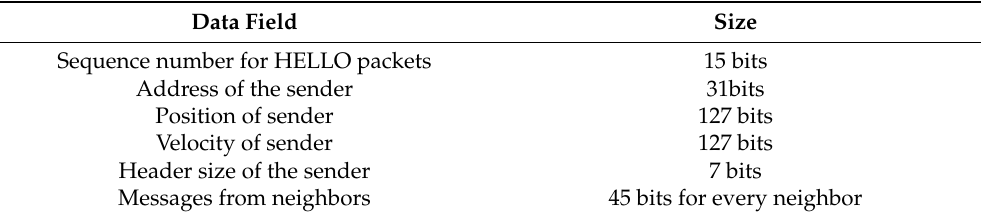
Table 2. Message format for MAC-based Neighbor Discovery